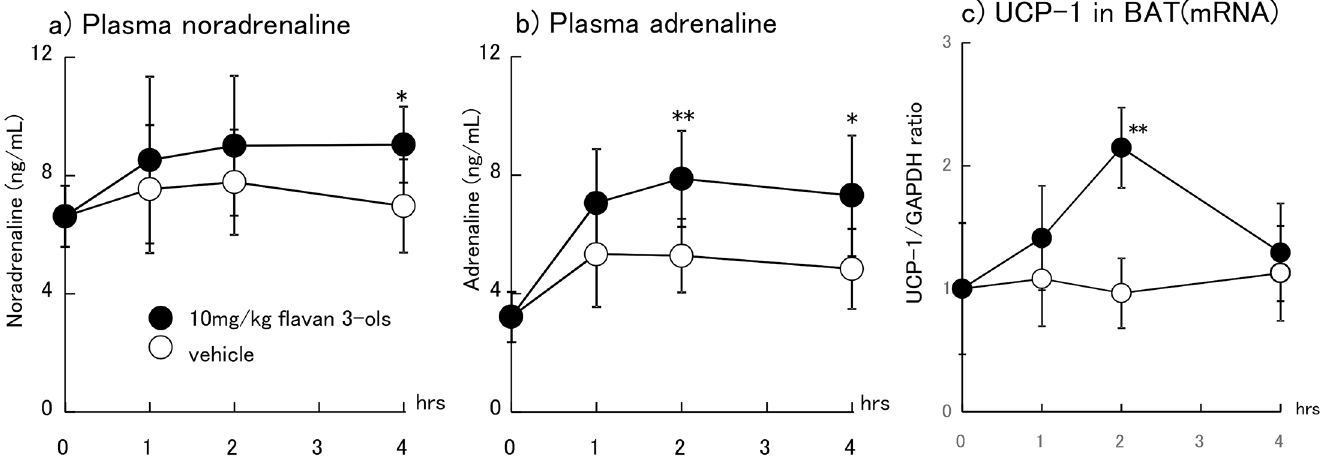
Fig 2. Alterations in plasma noradrenaline (a), adrenaline (b), and UCP-1 mRNA levels in BAT (c) after ingestion of 10 mg/kg flavan 3-ols or vehicle. The values represent mean ± standard deviation (each group, n = 8). (cid:3) p < 0.05, (cid:3)(cid:3) p < 0.01 (Tukey-Kramer test vs. vehicle).